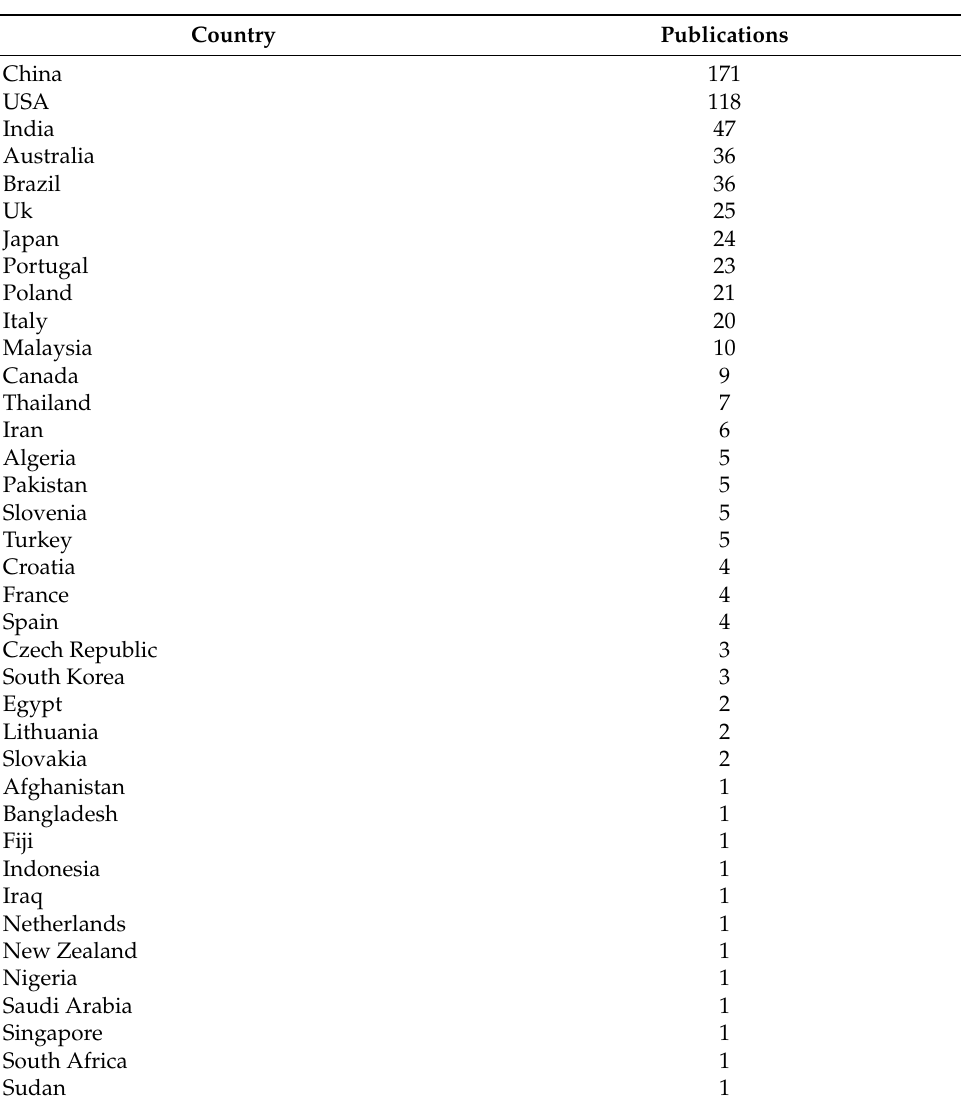
Table 3. Countries’ scientific production on geosyinthetics research entrenched with managerial implications, as considered in this study.